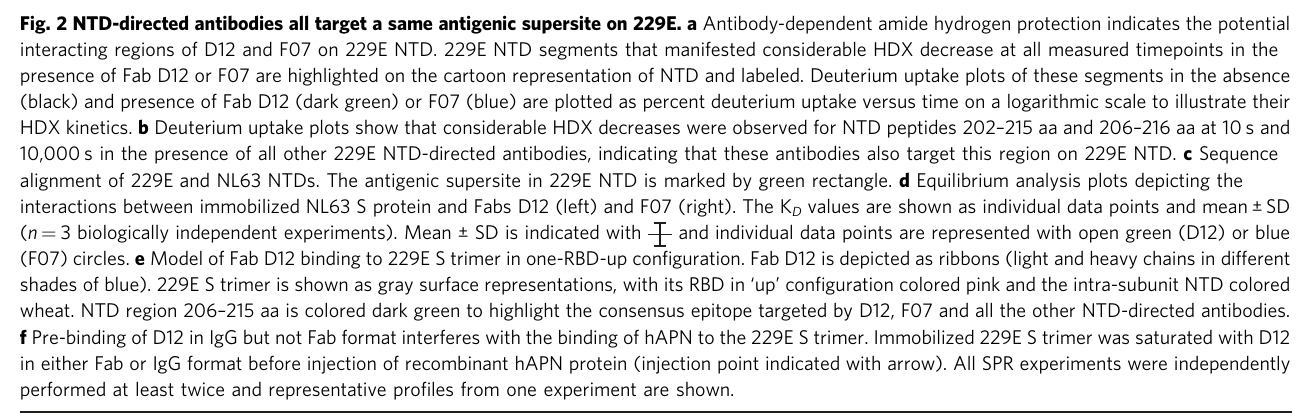
Fig. 2 NTD-directed antibodies all target a same antigenic supersite on 229E. a Antibody-dependent amide hydrogen protection indicates the potential interacting regions of D12 and F07 on 229E NTD. 229E NTD segments that manifested considerable HDX decrease at all measured timepoints in the presence of Fab D12 or F07 are highlighted on the cartoon representation of NTD and labeled. Deuterium uptake plots of these segments in the absence (black) and presence of Fab D12 (dark green) or F07 (blue) are plotted as percent deuterium uptake versus time on a logarithmic scale to illustrate their HDX kinetics. b Deuterium uptake plots show that considerable HDX decreases were observed for NTD peptides 202 – 215 aa and 206 – 216 aa at 10 s and 10,000s in the presence of all other 229E NTD-directed antibodies, indicating that these antibodies also target this region on 229E NTD. c Sequence alignment of 229E and NL63 NTDs. The antigenic supersite in 229E NTD is marked by green rectangle. d Equilibrium analysis plots depicting the interactions between immobilized NL63 S protein and Fabs D12 (left) and F07 (right). The K D values are shown as individual data points and mean ± SD ( n = 3 biologically independent experiments). Mean ± SD is indicated with and individual data points are represented with open green (D12) or blue (F07) circles. e Model of Fab D12 binding to 229E S trimer in one-RBD-up con fi guration. Fab D12 is depicted as ribbons (light and heavy chains in different shades of blue). 229E S trimer is shown as gray surface representations, with its RBD in ‘ up ’ con fi guration colored pink and the intra-subunit NTD colored wheat. NTD region 206 – 215 aa is colored dark green to highlight the consensus epitope targeted by D12, F07 and all the other NTD-directed antibodies. f Pre-binding of D12 in IgG but not Fab format interferes with the binding of hAPN to the 229E S trimer. Immobilized 229E S trimer was saturated with D12 in either Fab or IgG format before injection of recombinant hAPN protein (injection point indicated with arrow). All SPR experiments were independently performed at least twice and representative pro fi les from one experiment are